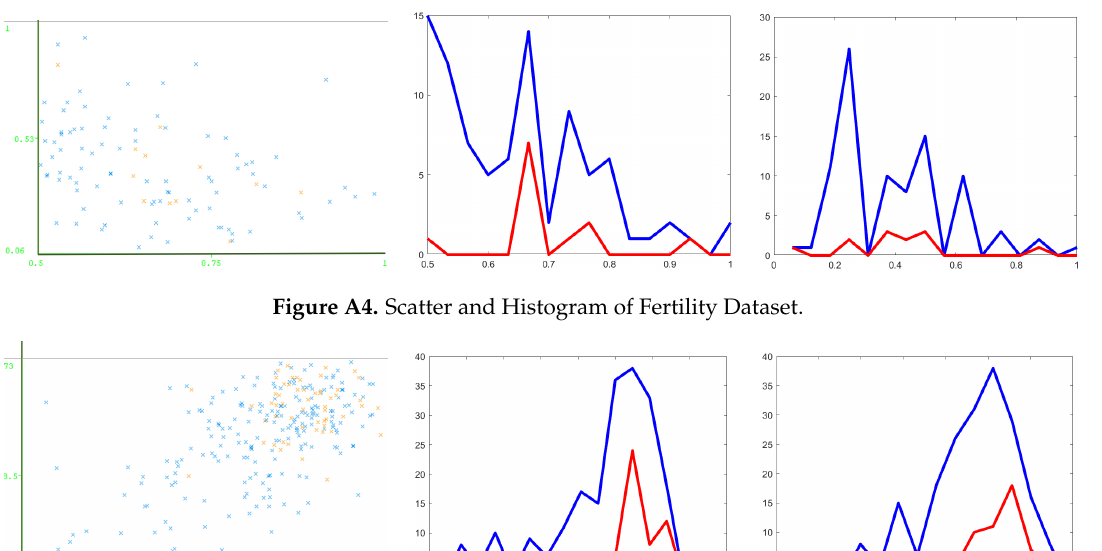
Figure A3. Scatter and Histogram of Glass Dataset.